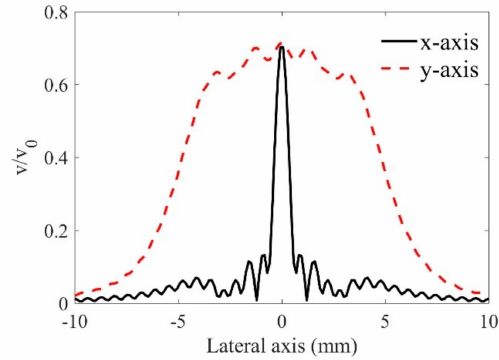
Figure 3. Particle velocities on the lateral axis at the focal